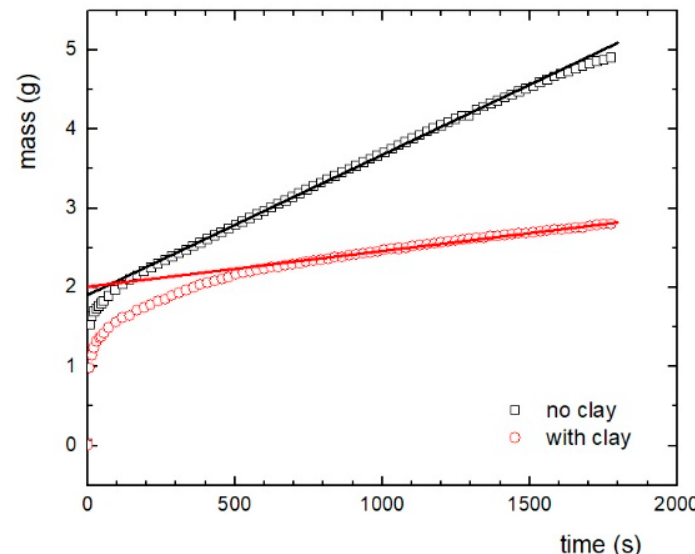
Figure 5. Sedimentation rate of MR slurry with and without clay added. The lines represent an approximate linear fashion with time to quantify the observed sedimentation rate.